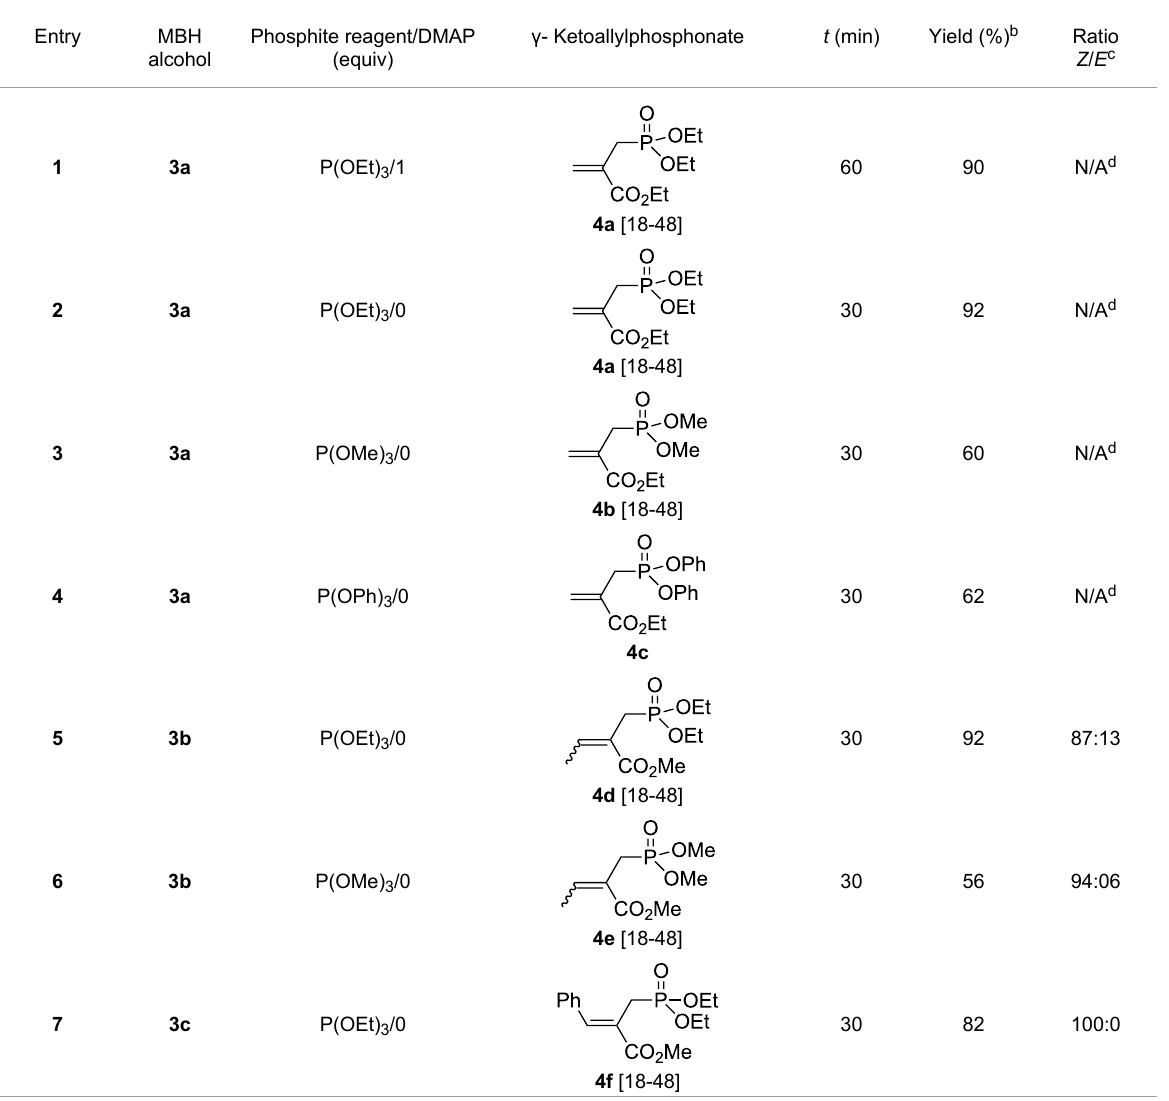
Table 3: Direct conversion of acyclic MBH alcohols 3a–c into γ -ketoallylphosphonates 4a–f a